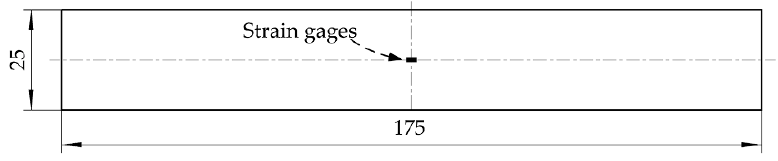
Figure A2. Dimensions of the transverse tensile specimens (mm).